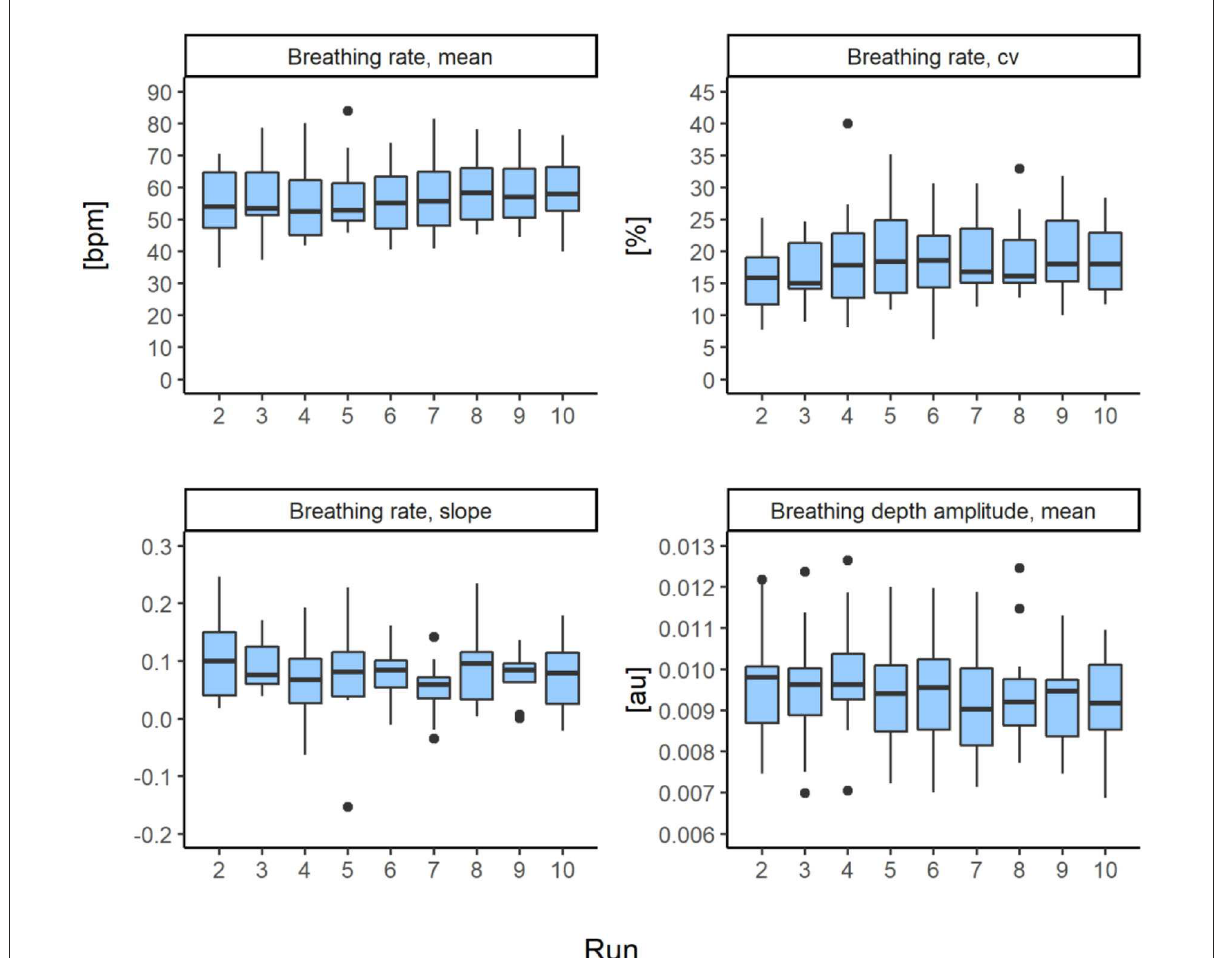
FIGURE3 Boxplots including outliers (1.5 times of the interquartile range) indicated as black dots of physiological parameters ( n = 12) per